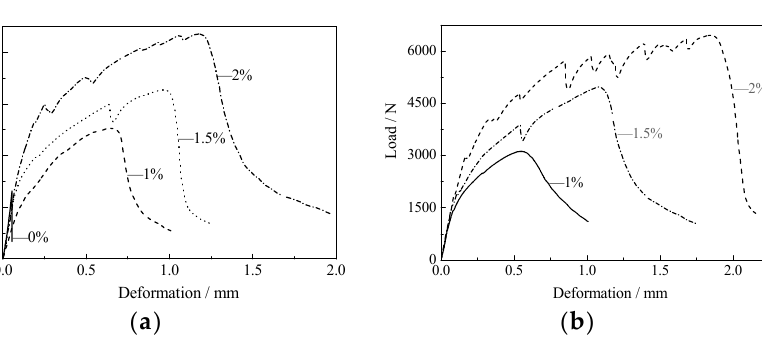
deflection curve of the HDC specimens and the influence of the different parameters on